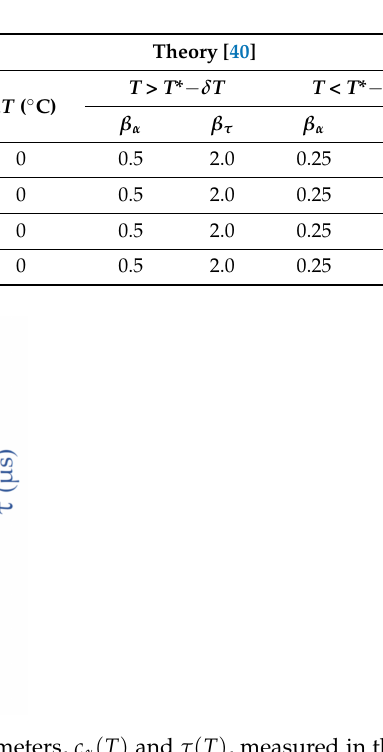
Table 2. Comparison of the ECE NTB parameters obtained from the power law fits of the experimental results with the predictions of the theoretical models.